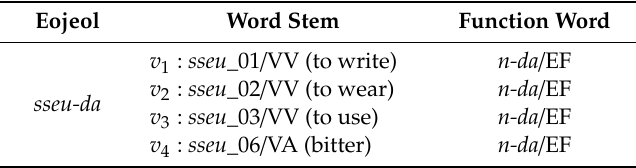
Table 5. An illustration of diverse word stems extricated from an eojeol. Eojeol Word